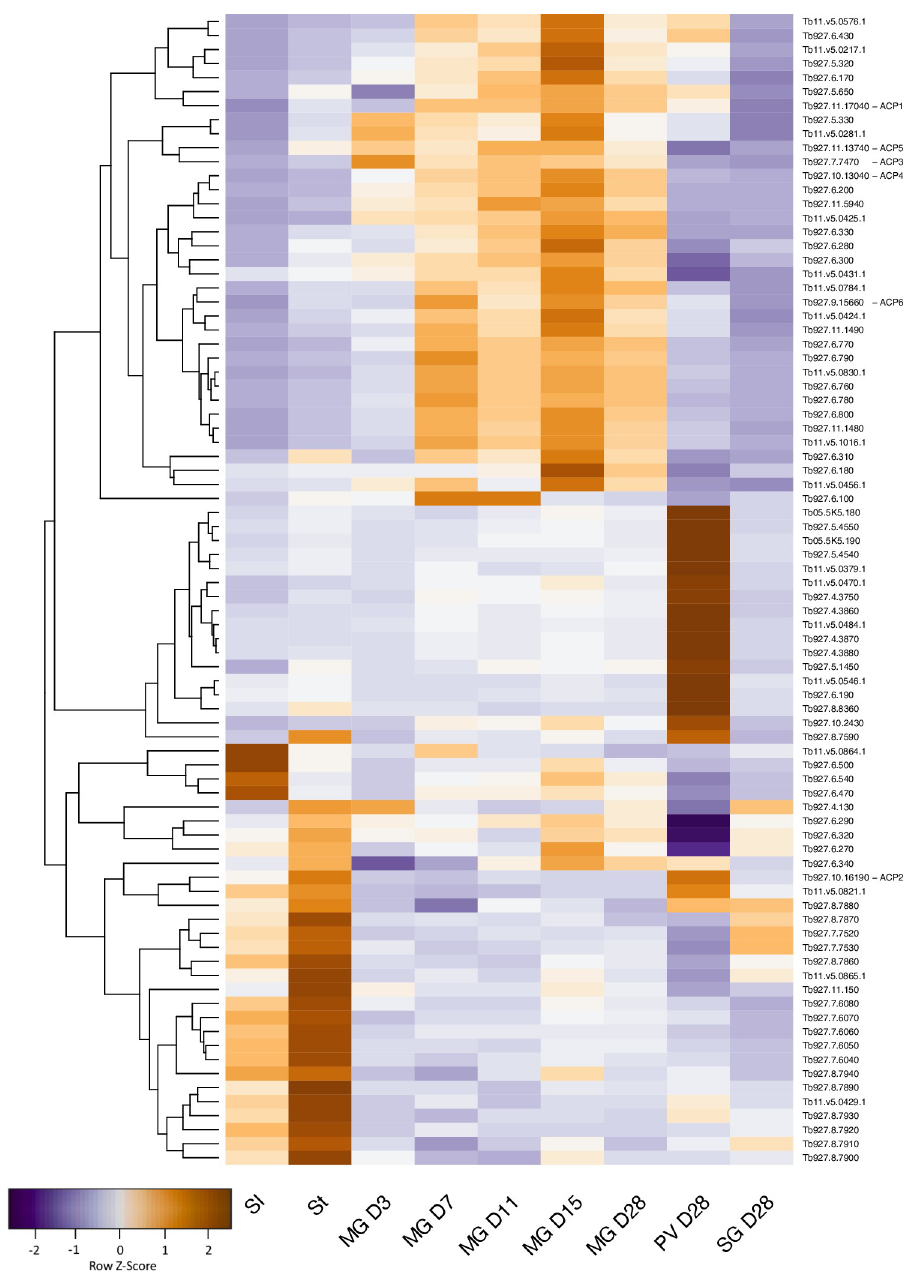
Fig 7. Gene expression heatmap of adenylate cyclases, with pseudogenes excluded. Rows indicate each gene and columns indicate samples. Data were z-score normalised. Colour scale: orange, high expression; blue, low